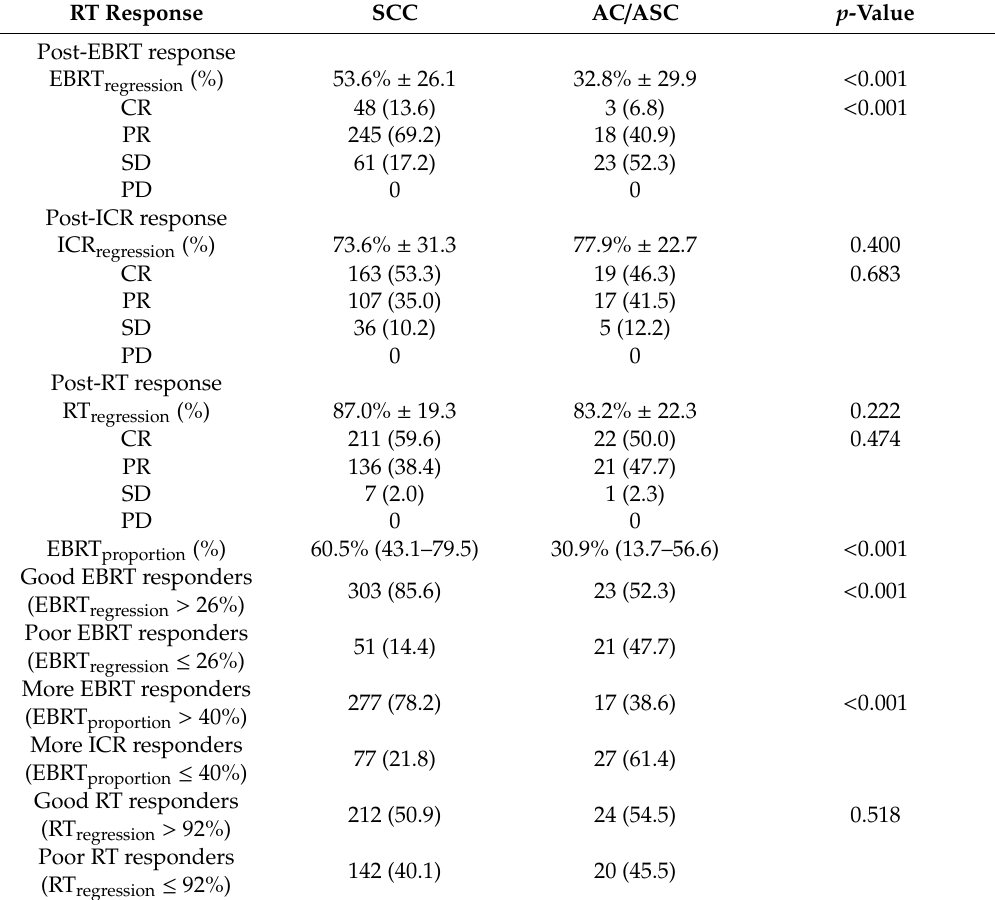
Table 2. Treatment response according to histologic subtype and radiotherapy phase during concurrent chemoradiotherapy